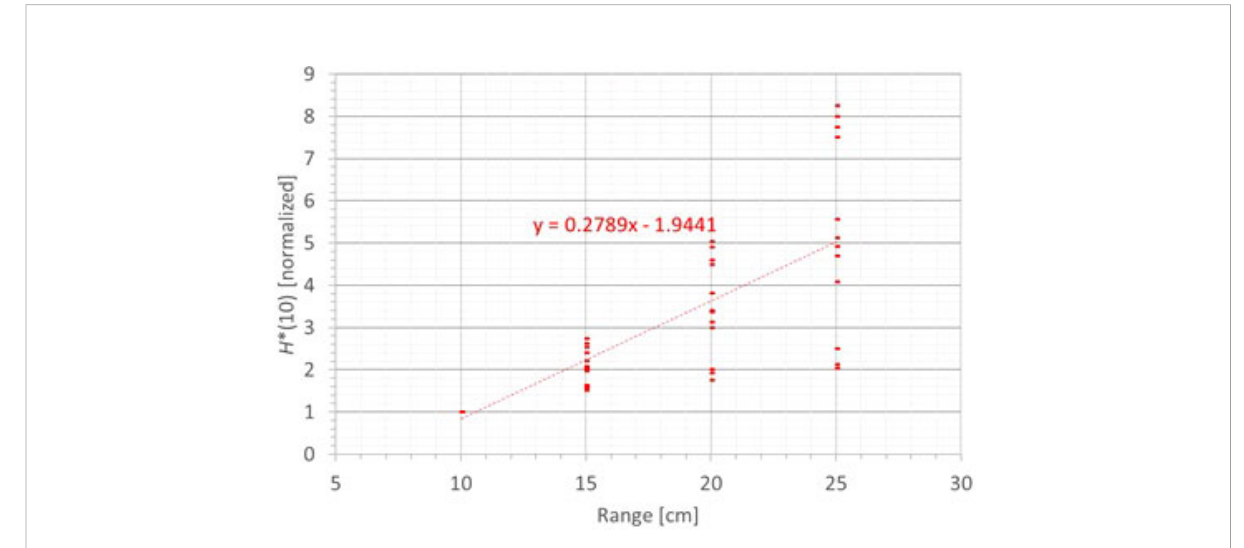
FIGURE 12 Plot of the variation of the simulated H*(10) as a function of the range for all modulation widths and positions for a fi eld size of 10 cm by 10 cm without a range shifter with a linear fi t through all the data